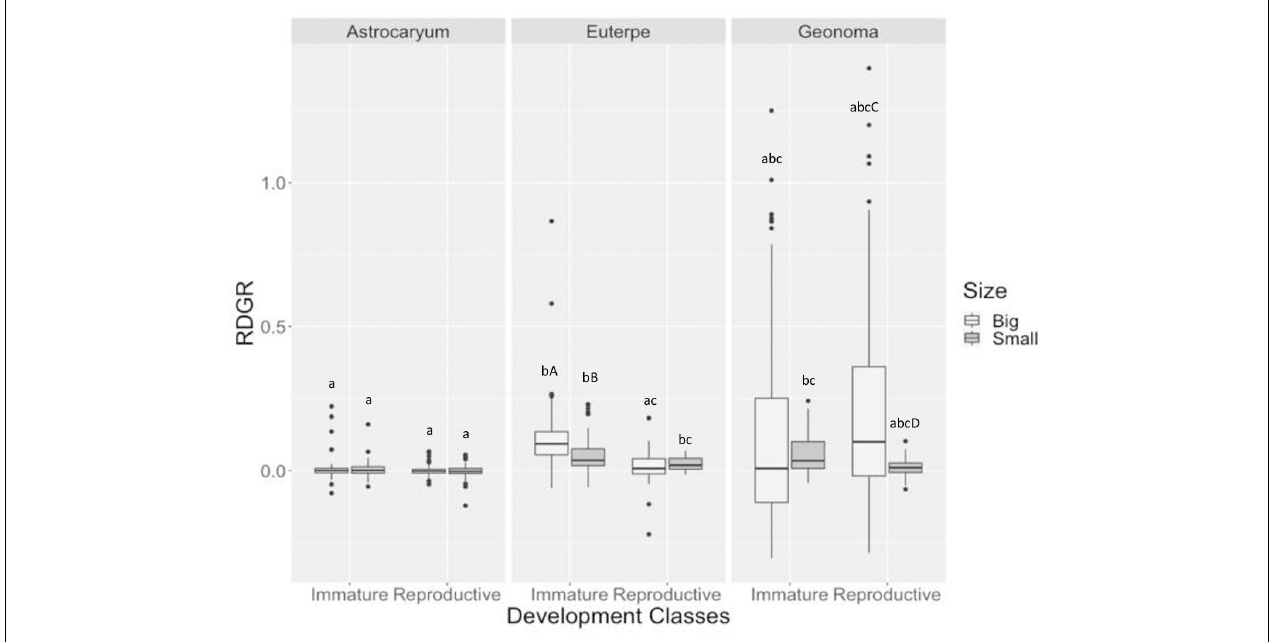
FIGURE 1 | Relative diameter growth rate (RDGR) of individuals of the demography plots (from year 2005 to 2007). The bootstrap confidence intervals were calculated for mean difference, lowercase letters indicate differences in the mean value of the attribute between species, and capital letters indicate differences between